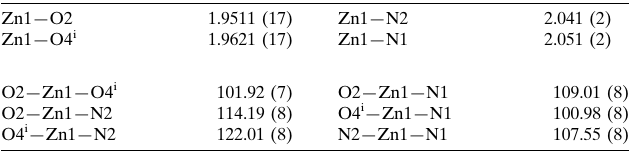
Selected geometric parameters (A˚ , (cid:2)